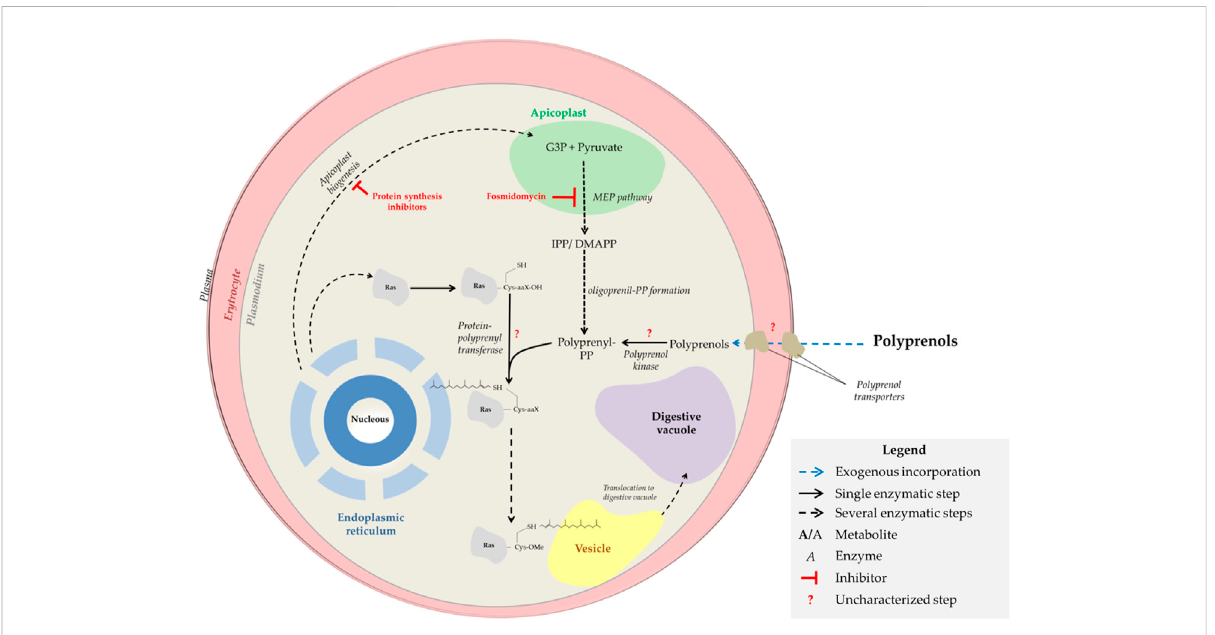
FIGURE 1 Isoprenoidsourcesanddistributioninmalariaparasites.Thescheme indicatesisoprenoidsourcesanddistributionas wellasfosmidomycinand ribosomal inhibitors targets in malaria